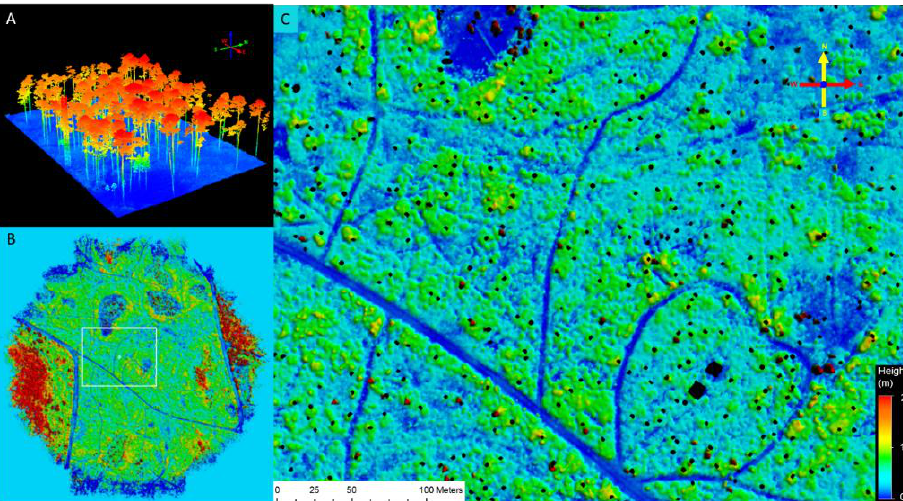
Figure 2. LiDAR images depicting ( A ) a select part of the study area that shows the ground surface, understory, and trees, ( B ) an understory canopy height map (CHM) estimated for the fire management unit and a ~6.5-hectare area (white rectangle) around the eddy-covariance tower, and ( C ) an understory CHM for the selected area showing the removed eddy-covariance tower, support structure (black squares), and trees (black dots). Near continuous blue areas are wetland depressions, roads, or fire breaks. Blue is the lowest understory canopy height (0 m or ground surface), and red is the highest (2 m).